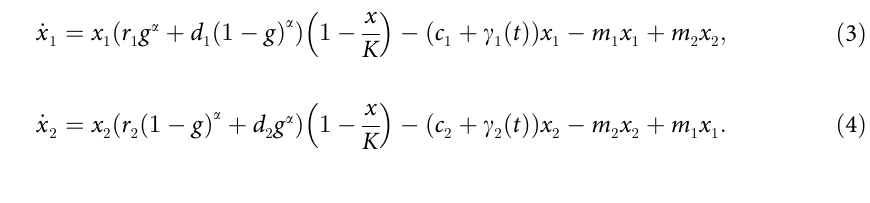
Fig 1. The heat map of tumor growth. Tumor growth, _ x ¼ _ x where the types’ growth rates are modulated by a pure coordination game. Type 1’s intrinsic growth rate, r 1 , is larger and its death rate, c 1 , is lower, therefore its fitness peak is higher, but a pure type 2 tumor also has a fitness peak. Parameters: r 1 = 0.25, r 2 = 0.17, d 1 = d 2 = 0, K = 100, T = 10, α = 2, c 1 = 0.05, c 2 = 0.1, m 1 = m 2 = 0.01.